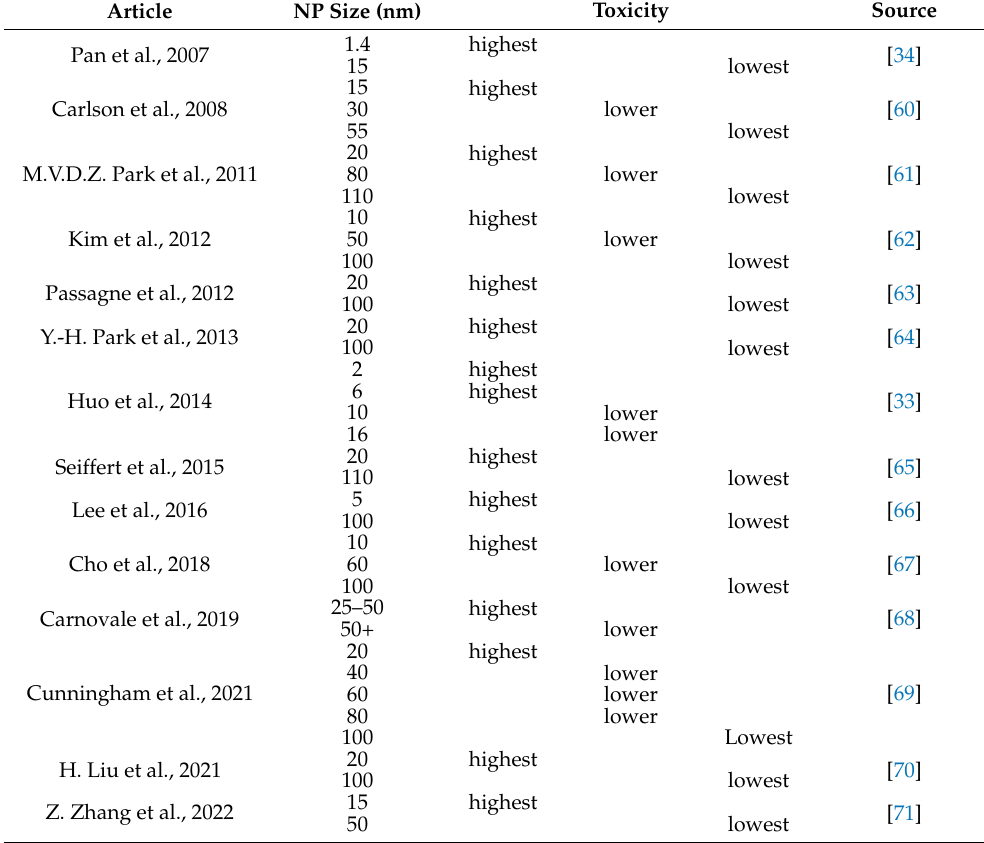
Table 1. Comparison of size–toxicity results from different publications.